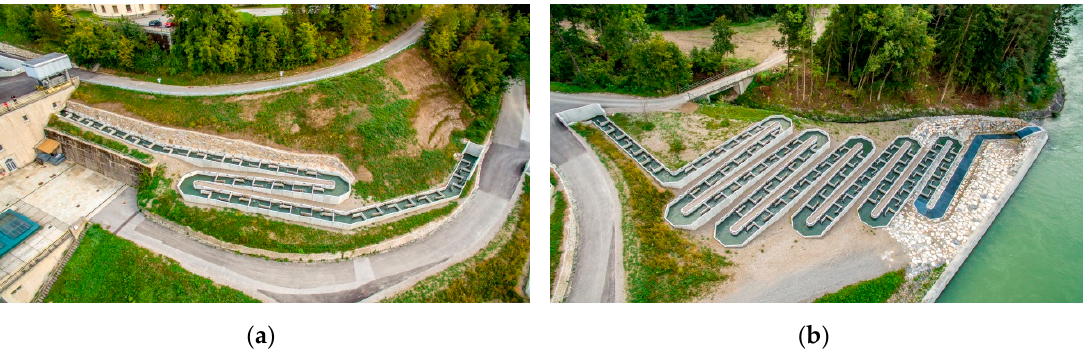
Figure 1. The enature ® fish pass at the Schwabeck Hydro Power Plant (HPP), Drava River, Carinthia/Austria: middle section (a) , lower section, and entrance (b).